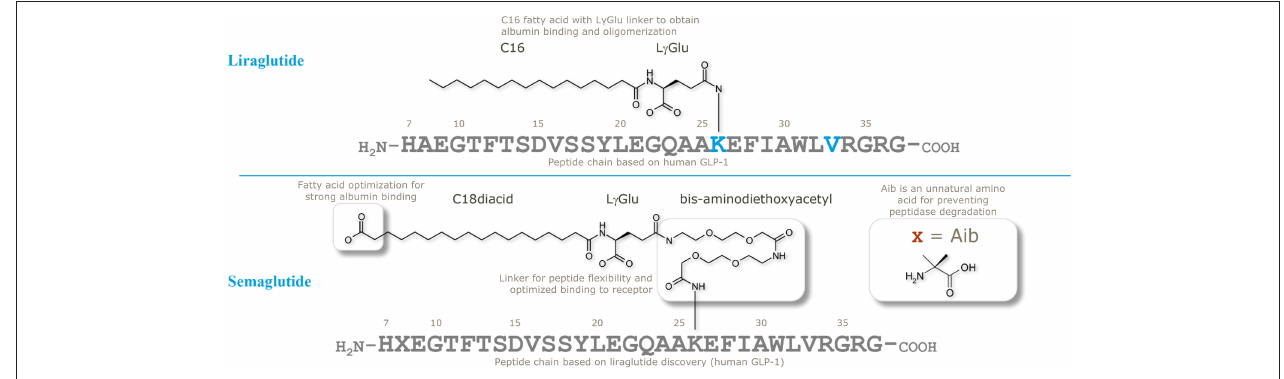
FIGURE 2 | Chemical structures of liraglutide and semaglutide. Adapted with permission from Lau et al. (53). Copyright 2018, American Chemical Society.